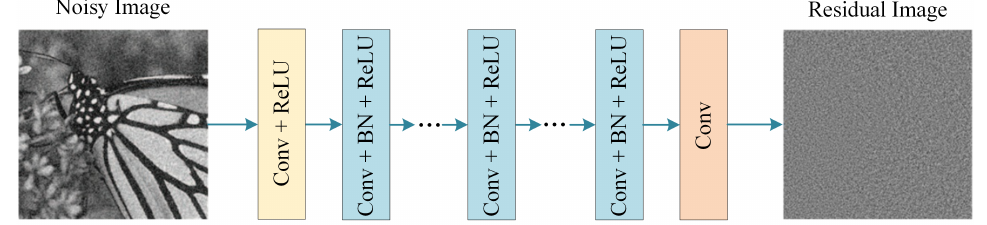
Figure 9. Schematic diagram of the network structure of DnCNN